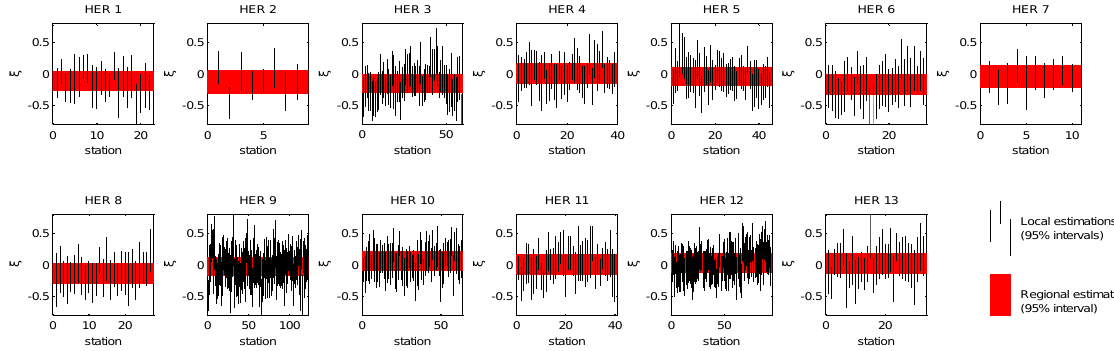
Fig. A1. Comparison of local and regional estimates of the shape parameter of a GEV distribution in each of the 13 hydroecoregions (HER).